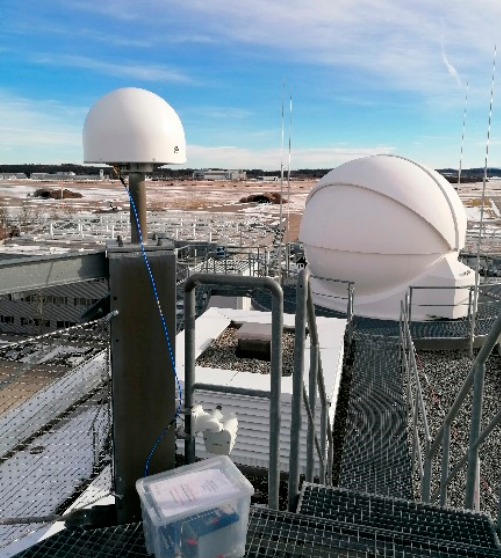
Figure 11. Example of reference antenna mounted in a more challenging environment, in this case, the rooftop of DLR’s Institute of Communications and Navigation.